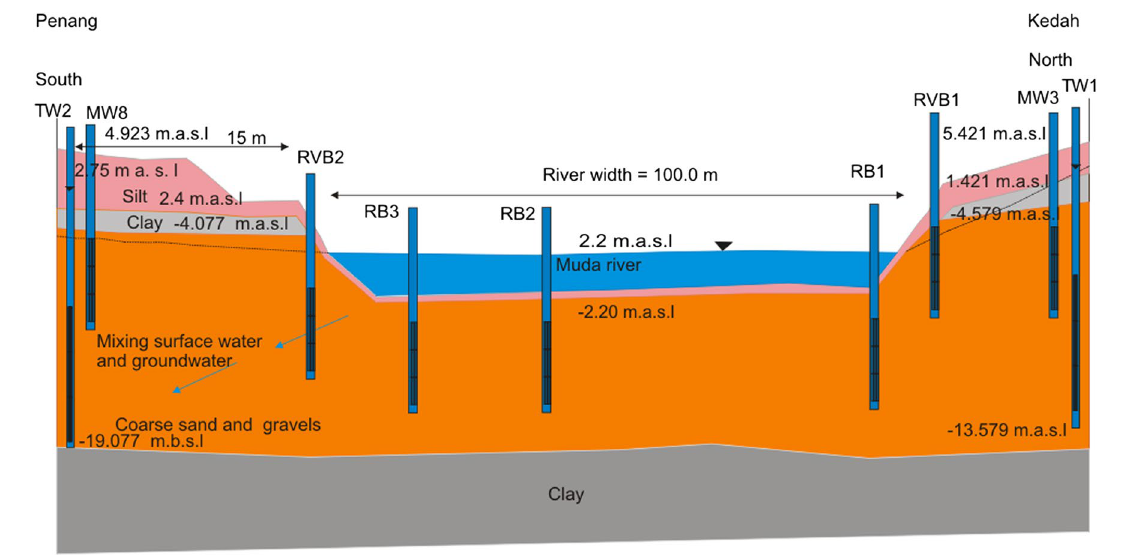
Fig. 2 Schematic hydrogeological cross sections, illustrating the riverbank and streambed in Muda River